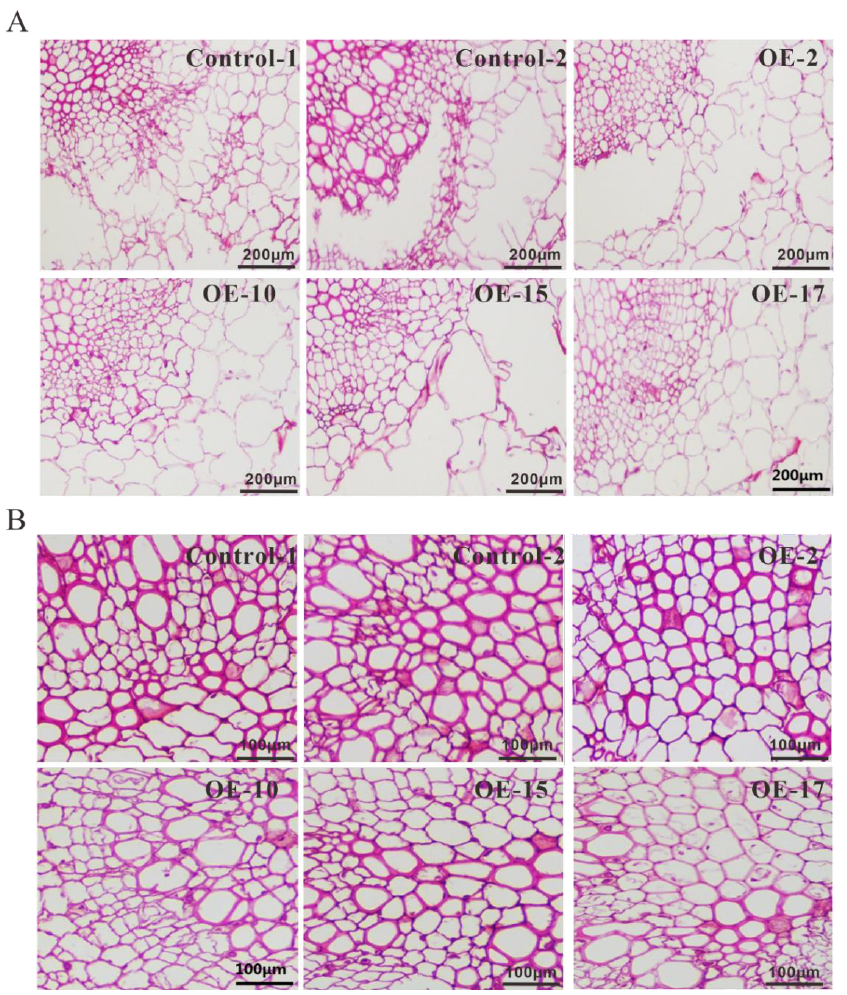
Figure 8. Histochemical stain of lignin in the roots of SmLAC3 -OE and control lines. ( A ) Lignin staining in the roots of the control and transgenic lines. Scale bar denotes 200 µ m. ( B ) Magnified views of images in A. Scale bar denotes 100 µ